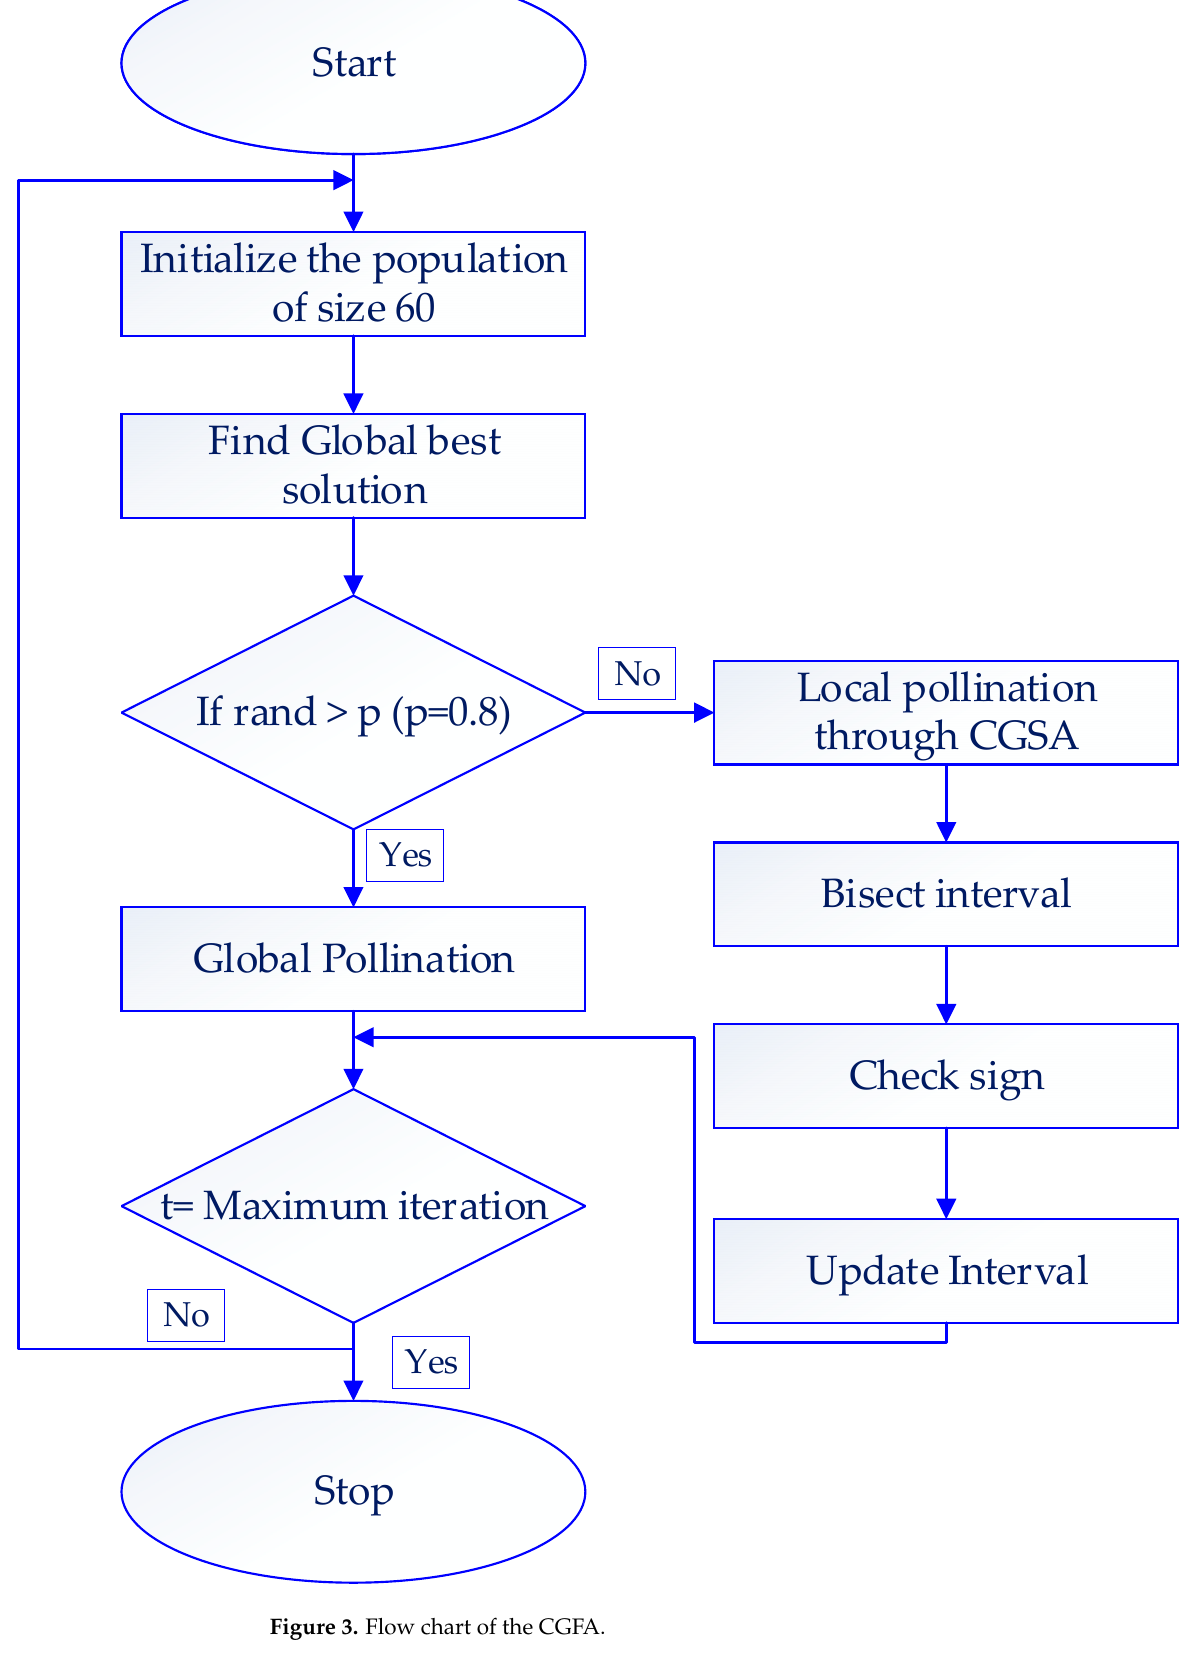
Figure 3. Flow chart of the CGFA.